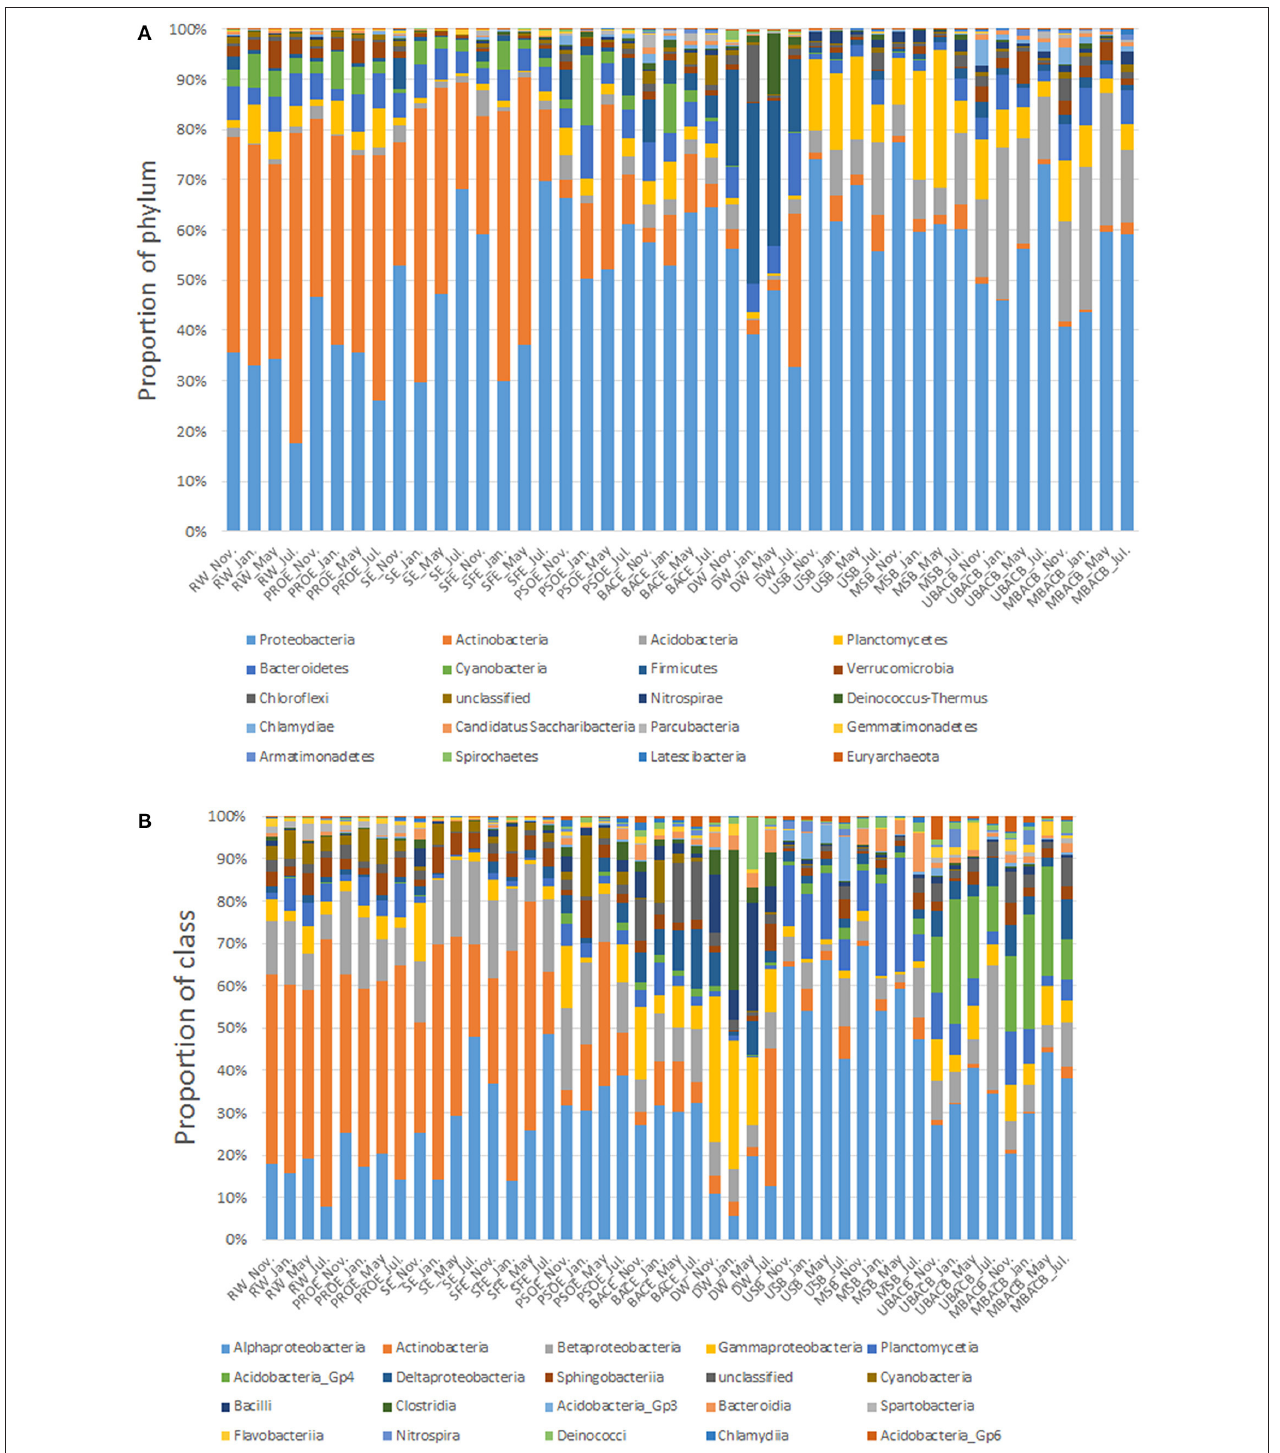
FIGURE 3 | Relative abundance of bacterial phyla (A) and classes (B) at each treatment step. The top 20 most abundant phyla or classes are shown. The abbreviations are the same as used in Table 2 .